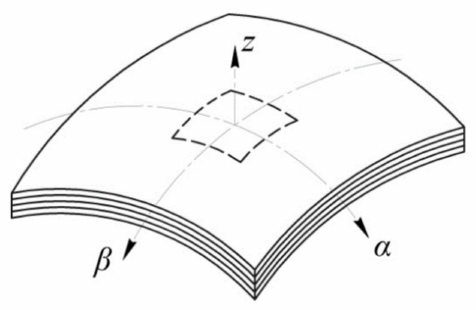
Figure 2. Geometric parameters of the panel of step-variable thickness.